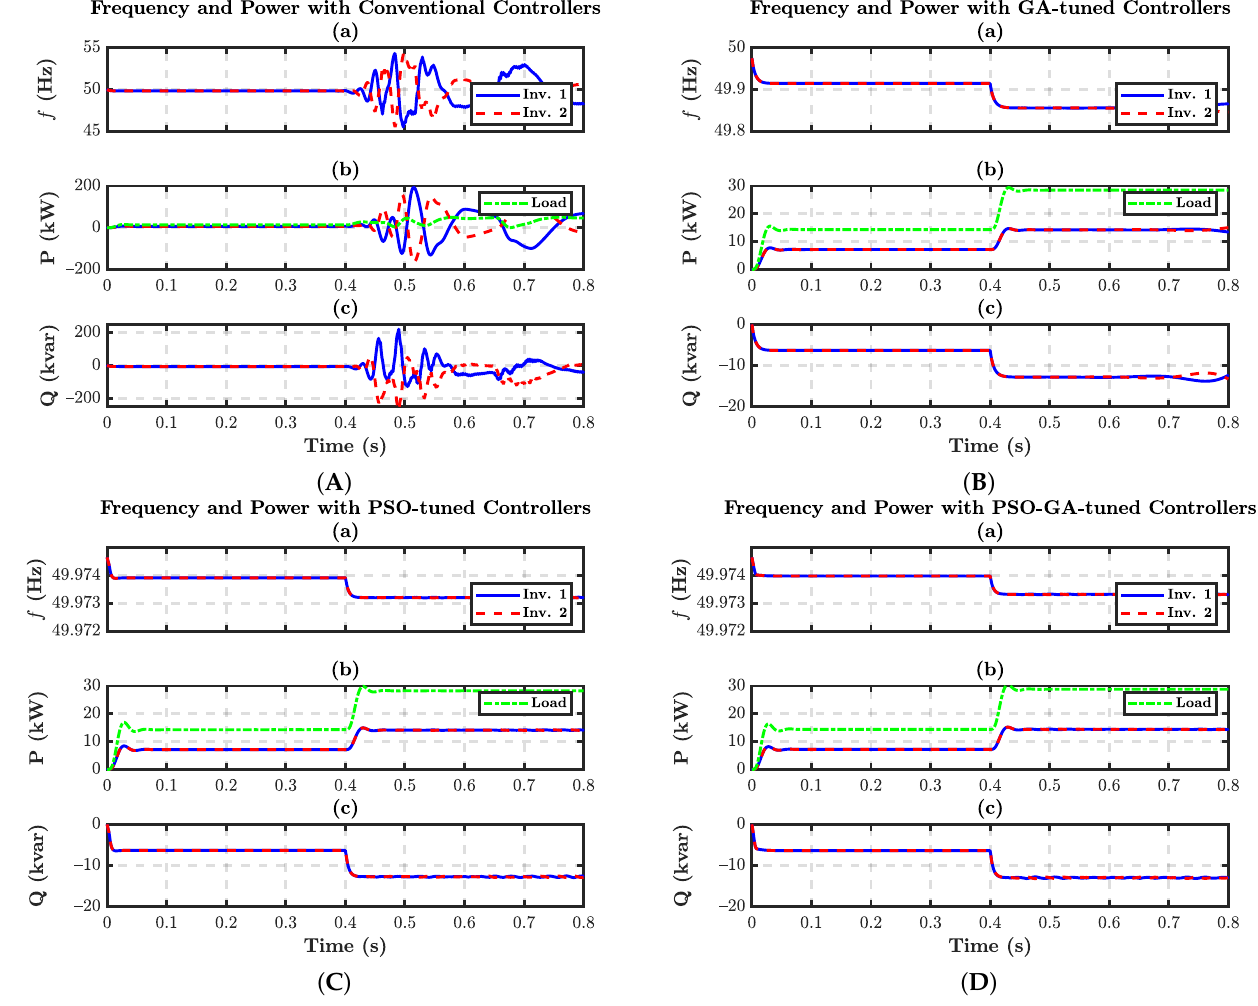
Figure 28. The frequency, the active, and the reactive power in two-inverter MG: ( A ) conv.; ( B ) GA; ( C ) PSO; ( D ) PSO-GA. ( a ) frequency; ( b ) active power; ( c ) reactive